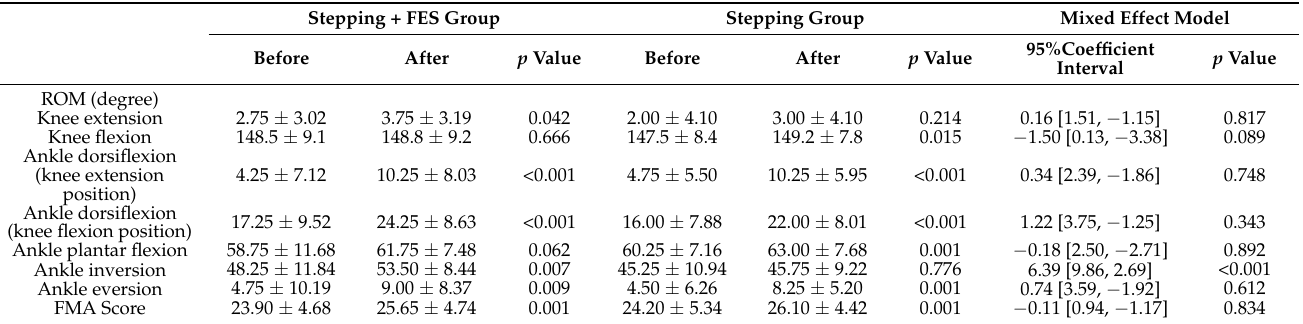
Figure 2. Scatter plot to compare changes in 10 m walking speed (10MWS) after stepping + FES treatment and stepping alone treatment in the same patients. The ordinate represents changes in 10MWS after stepping + FES treatment and the abscissa represents changes in 10MWS after stepping alone. Points above the line y = x denote better improvement after stepping alone, while those below the line indicate better improvement in the stepping + FES group. Table 3. ROM and FMA scores before and after the